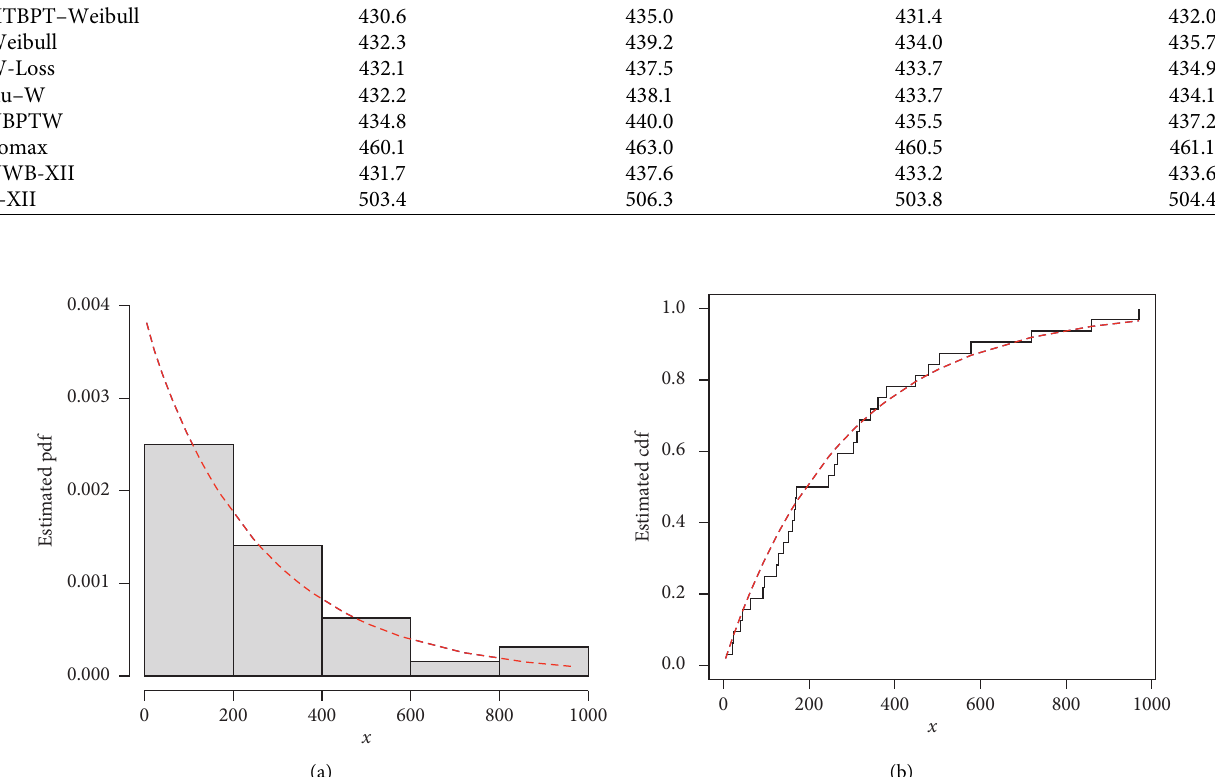
Figure 13: The estimated pdf and cdf of the HTBPT–Weibull distribution for the vehicle insurance loss data.